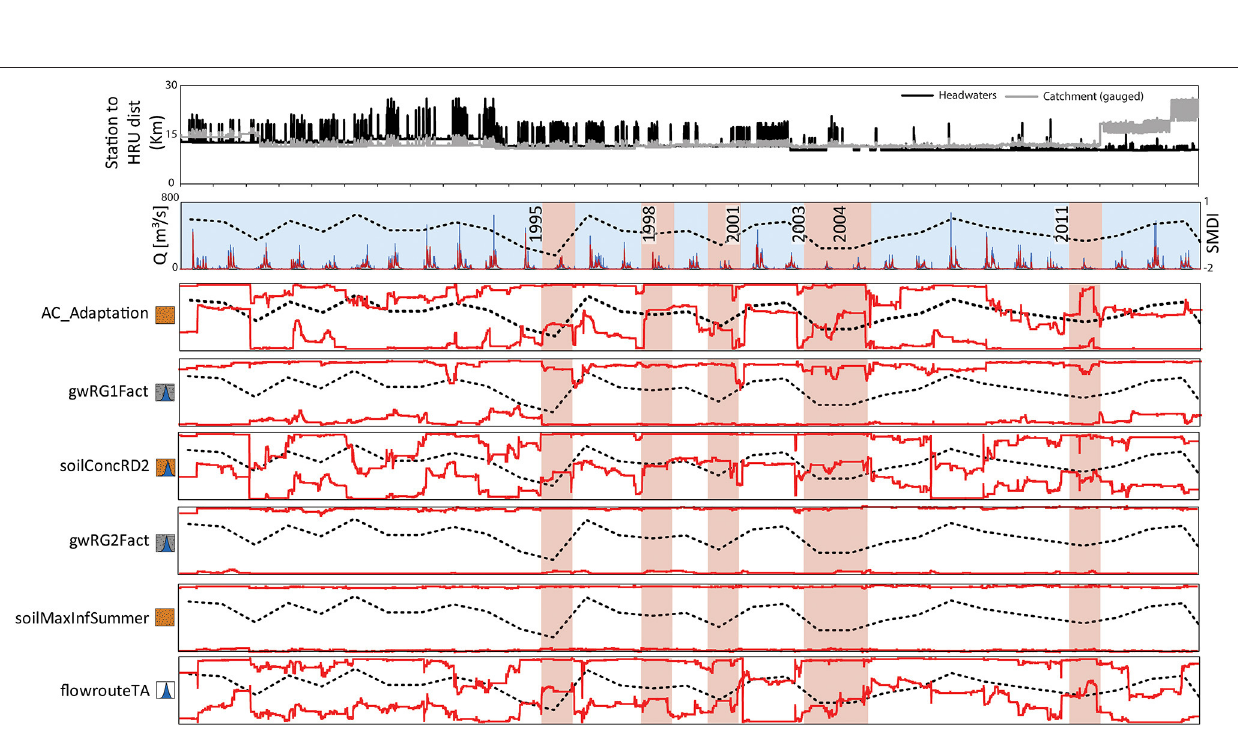
Frontiers in Climate |